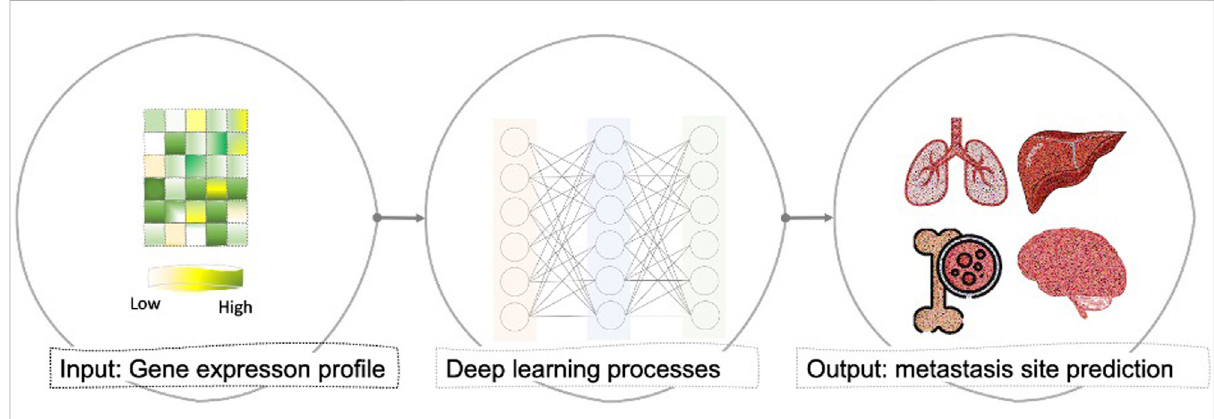
FIGURE 1 General overview of the proposed computational framework that takes the gene expression pro fi le of any primary cancer sample and predicts whether patients ’ samples are primary (localized) or had been metastasized to brain, bone, lung, or liver based on deep learning architecture.